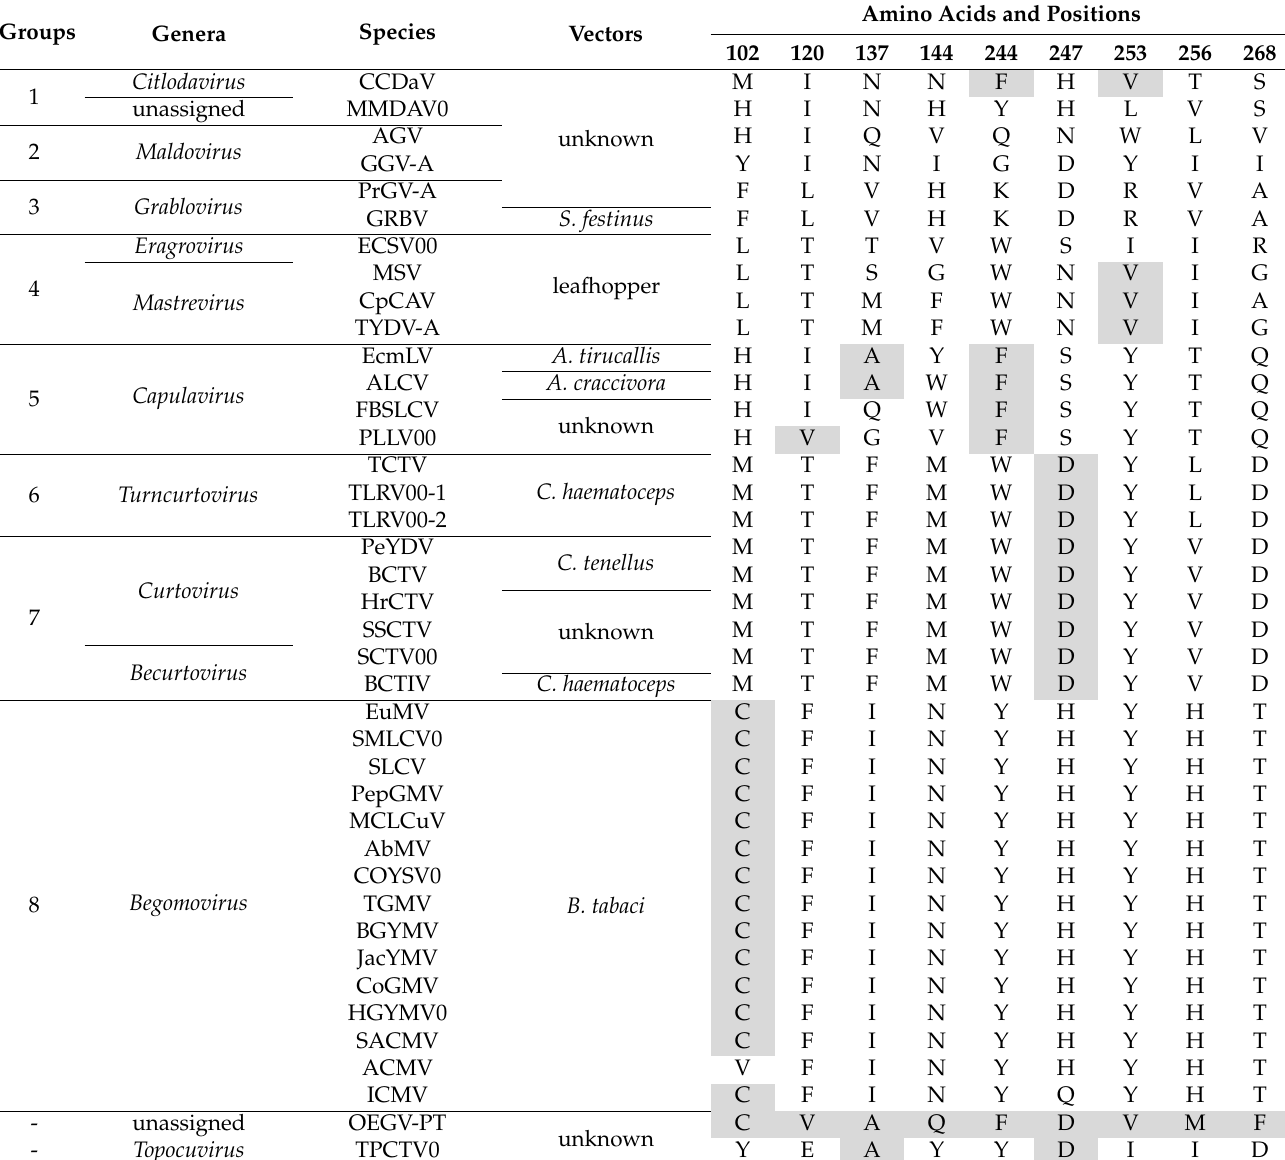
Table 2. Specificity-determining positions (SDPs) alignment for the CP amino acid sequences of the geminivirirus. CP multiple sequence alignment by clustalX code. The sequences were automatically divided into eight groups by SCI-PHY and SDPs calculated by the SPEER server. The columns indicate the groups, genera, virus species (acronym), known insect vectors, the aa predicted to determine differences in virus vector specificity and respective positions in the CP multiple alignments. The gray boxes indicate the homologies in the specific